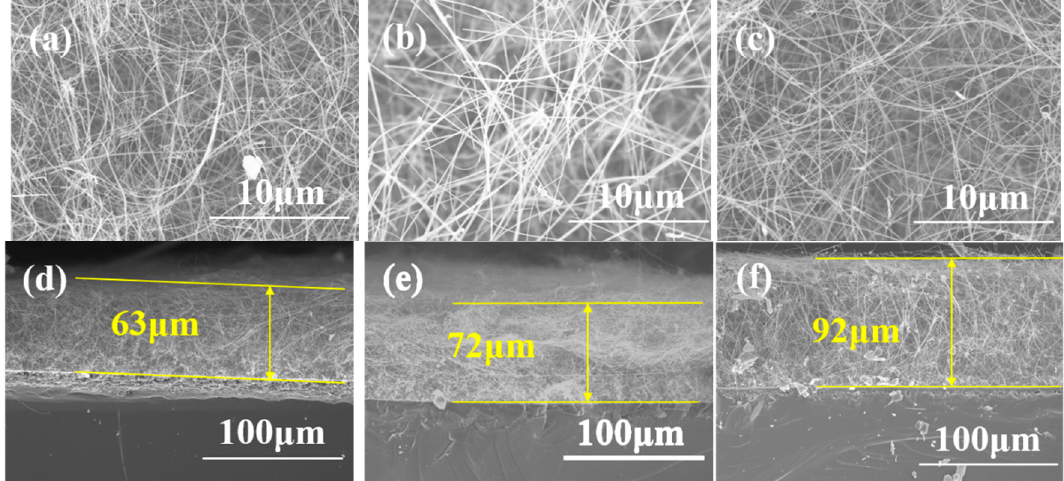
Figure 2. Surface morphology SEM images of ( a ) N1, ( b ) N2, ( c ) N3 SiC nanowires, Cross-section morphology SEM images of ( d ) N1, ( e ) N2, ( f ) N3 SiC nanowires.